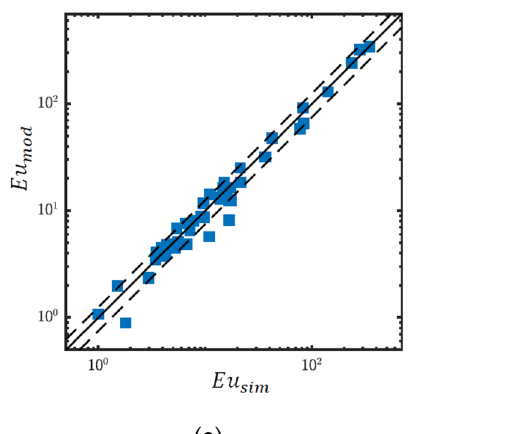
Figure 11. Comparison of the heat exchanger transmission capacity in terms of pressure drop for a variation of heat exchanger geometric parameters.